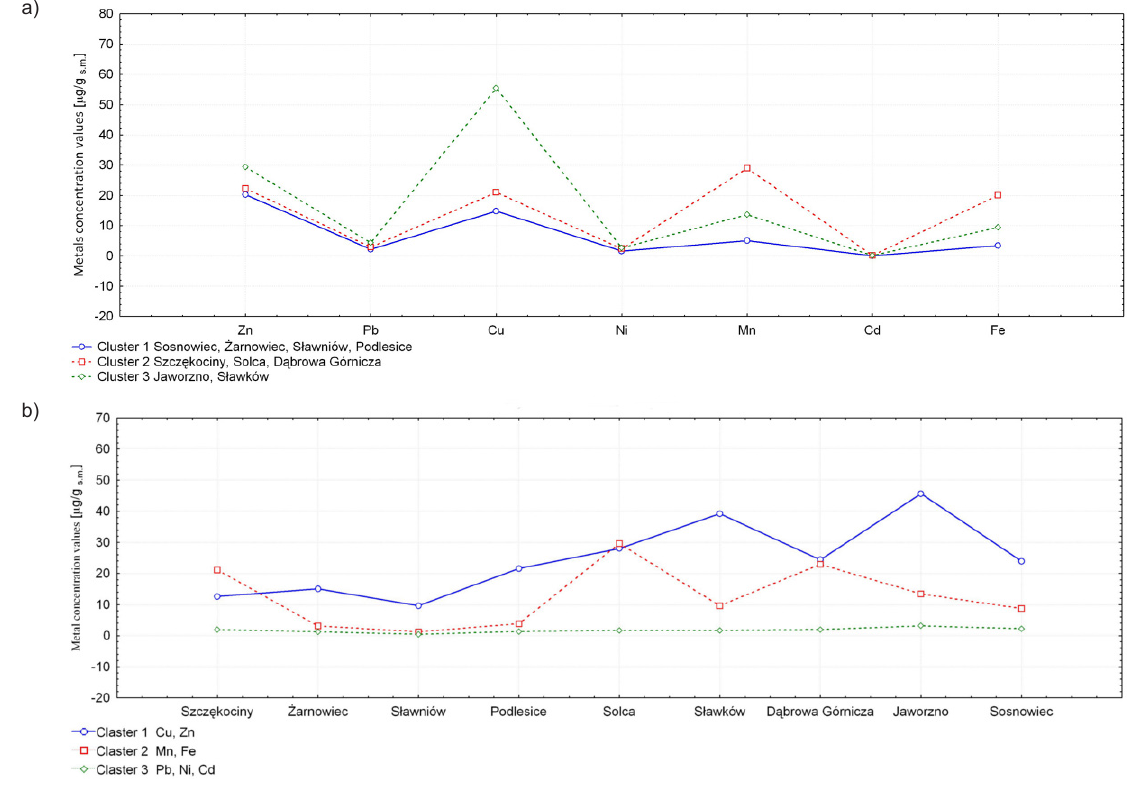
Figure 4. a) Diagram of the k-means analysis for metal content in relation to three agglomerations describing the sampling sites, b) diagram of the analysis of k-means for sampling sites in relation to three agglomerations describing the metal Fig. 5 shows the distribution of sampling sites from which samples were collected for analysis. Industrial areas were marked as (1), while non-industrialised places were marked as (2) or (3).